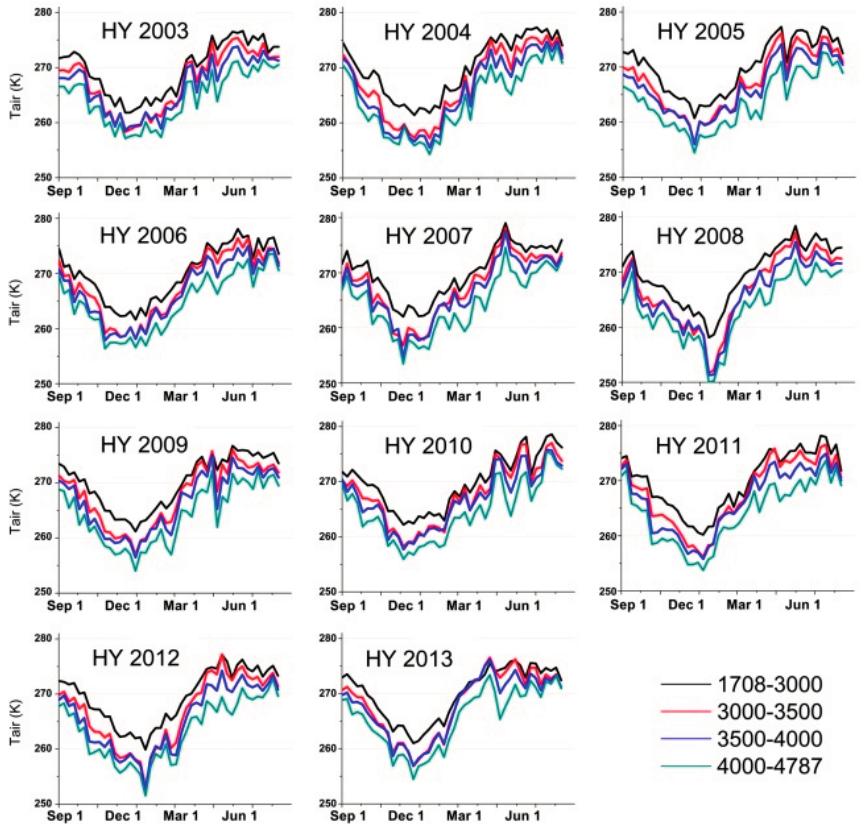
Figure 6. The simulated annual cycle of T air (k) for four different elevation zones for HY 2003 to HY